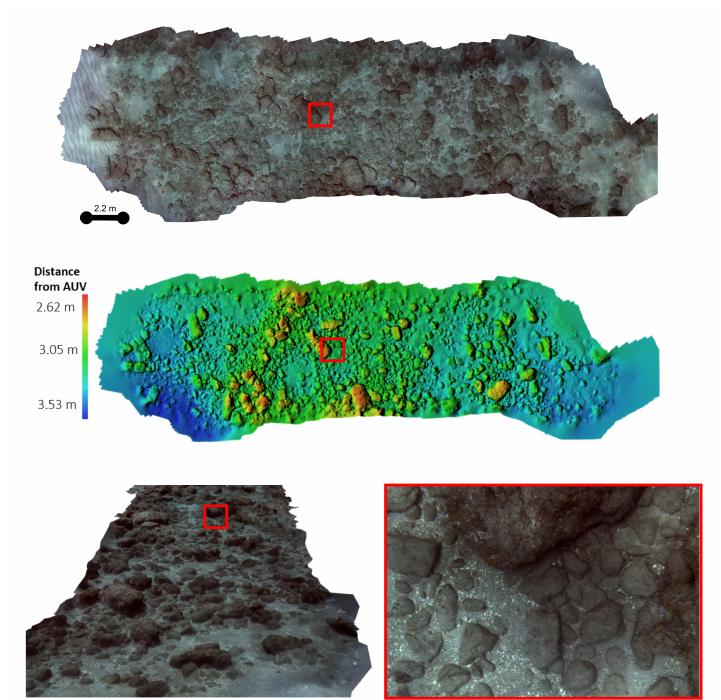
Figure 33. 3D mosaic of a Roman underwater harbor, in Caesarea, Israel. ( Top ) Mosaic of an area of 8 m × 27 m; ( Middle ) 3D reconstruction of the same area; ( Bottom left ) another viewpoint of the reconstructed 3D; ( Bottom right ) zoom-in of an area marked with a red rectangle in the top mo- saic. Full model can be viewed in https://sketchfab.com/3d-models/caesarea-roman-underwater- harbour-da2ca77fcf6141bb8e1261fb6f1d1187, accessed on 13 May